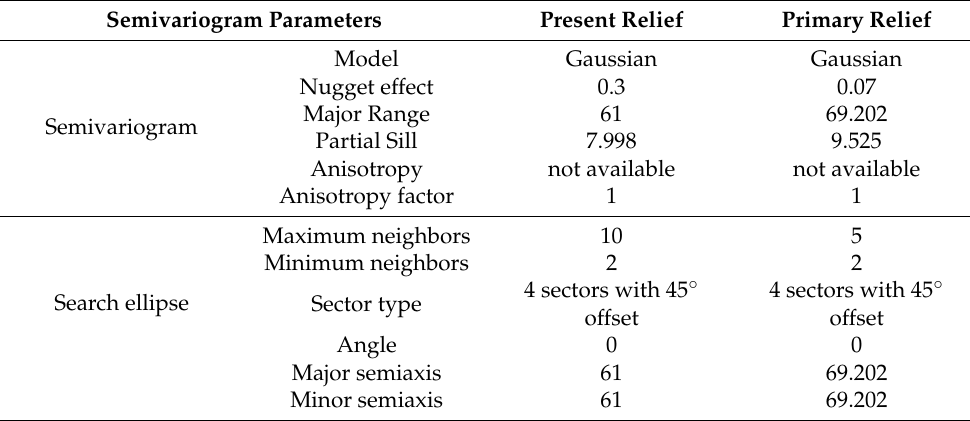
Figure 6. Experimental variograms and fitted theoretical models in relief modelling for the variable used (elevation): ( a ) present relief; ( b ) primary relief. Blue crosses and lines are experimental semivariograms and theoretical Gaussian models, respectively. Table 2. Parameters of theoretical semivariogram